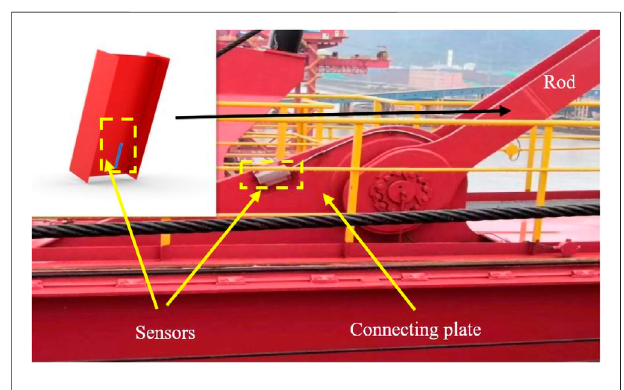
FIGURE 7 | Sensor layout